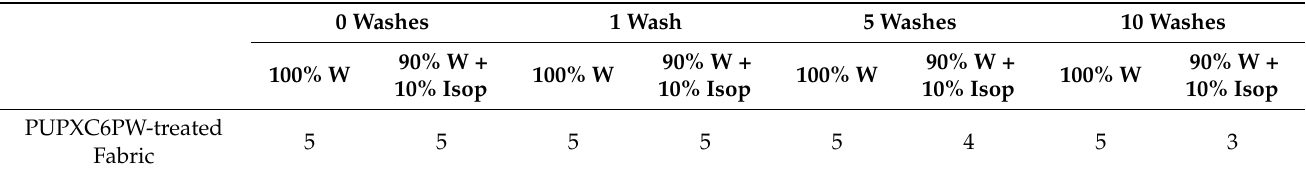
Table 3. Spray test results with 100% water and (90/10) (water/isopropyl alcohol).